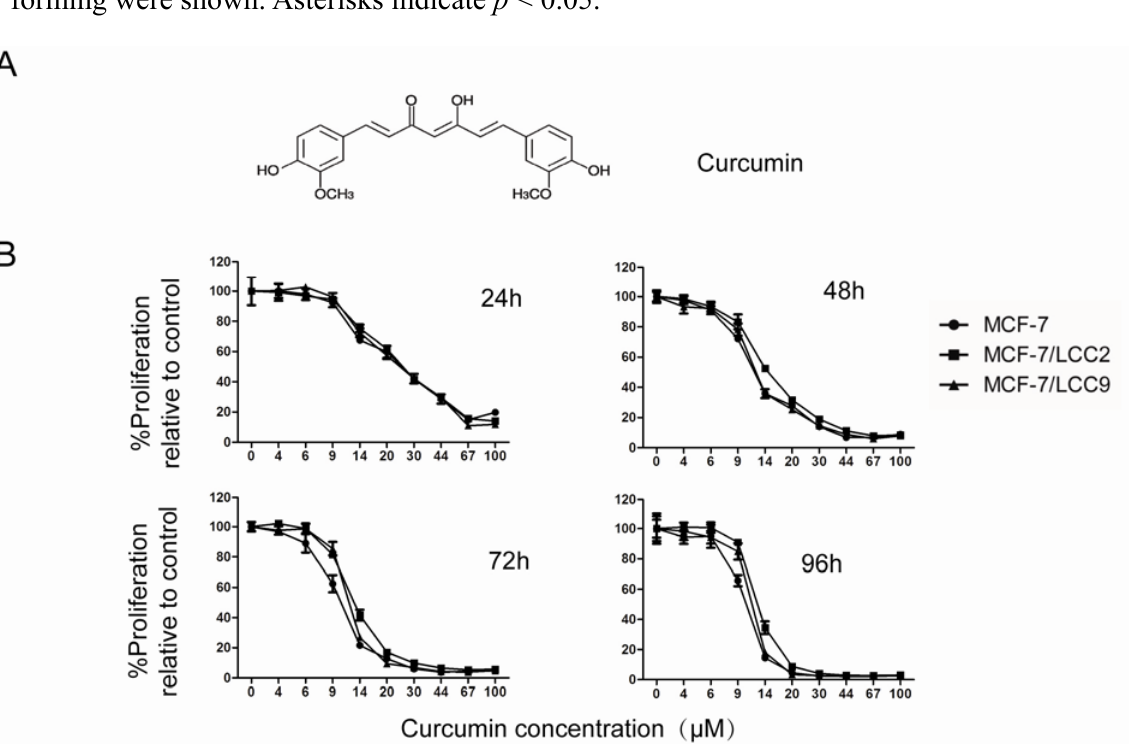
Figure 1. Curcumin inhibits proliferation of MCF-7/LCC2 and MCF-7/LCC9. ( A ) The chemical structure of curcumin; ( B ) Cells were treated with varying concentrations of curcumin, cell proliferation and IC50 were determined by SRB assay on days 1, 2, 3 and 4. Each value represents the mean ± SD (n = 3); ( C ) Curcumin suppressed colony formation in endocrine resistant cells. Cell were treated with curcumin (10 and 30 μ M) and were allowed to form colonies in fresh medium for 14 days. Photomicrographic difference (Left panel) and influence of cell number (mean ± SD. n = 3) (Right panel) in colony forming were shown. Asterisks indicate p <